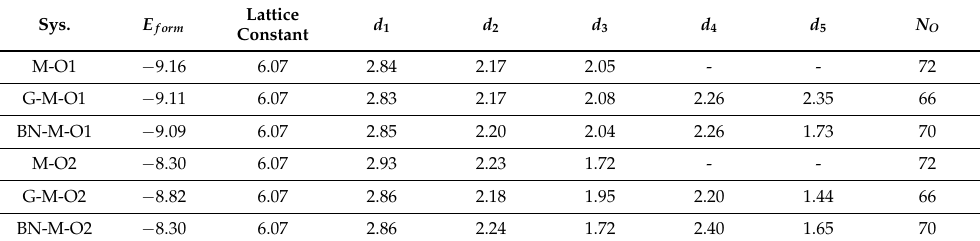
Figure 1. The top and side views of the unterminated ( a ) M, ( b ) G-M, and ( c ) BN-M systems. The projections of the terminations O1 and O2 are shown in ( a ). Mo, C, B, and N atoms are shown in gray, yellow, green, and pink, respectively. Table 1. The calculated formation energy ( E form eV), lattice constant (Å), average bond length (Å) of Mo-Mo ( d 1 ), Mo-C ( d 2 ), Mo-O ( d 3 ), Mo-patch ( d 4 ) and C-patch ( d 5 ), and the number of O-termination atoms ( N O